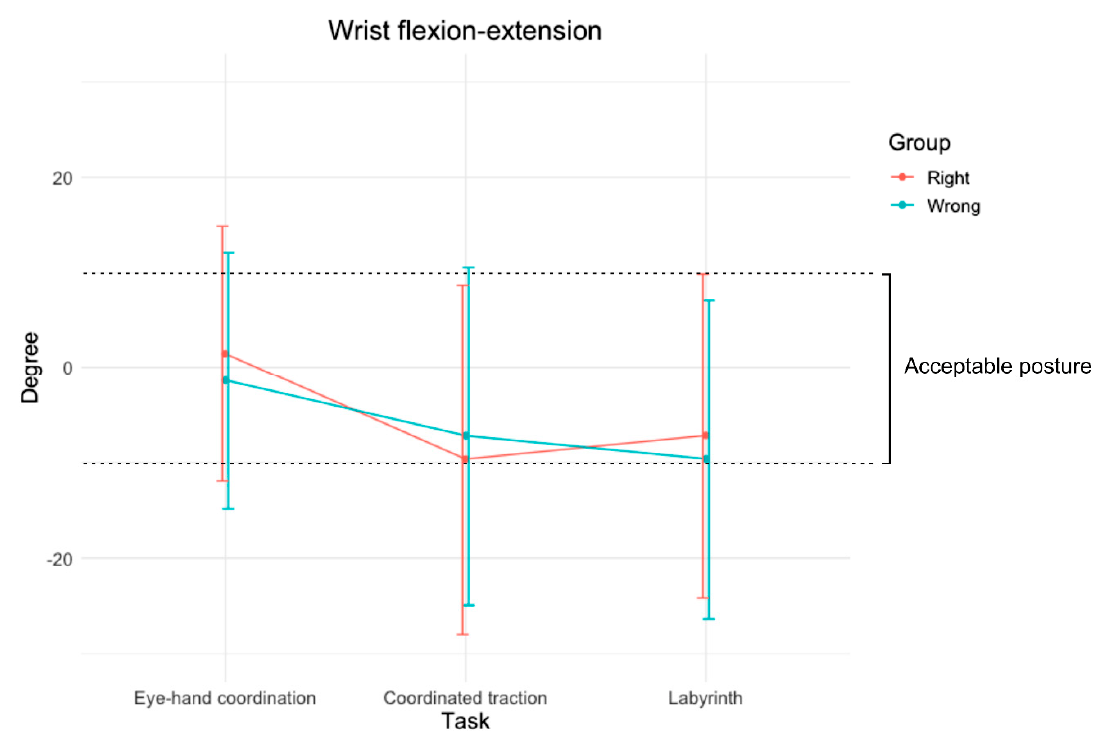
Figure 7. Radio-ulnar deviation of the surgeons’ wrist during the laparoscopic tasks using the right and wrong size of instrument handle. The graph indicates the acceptable posture of the wrist according to RULA method.